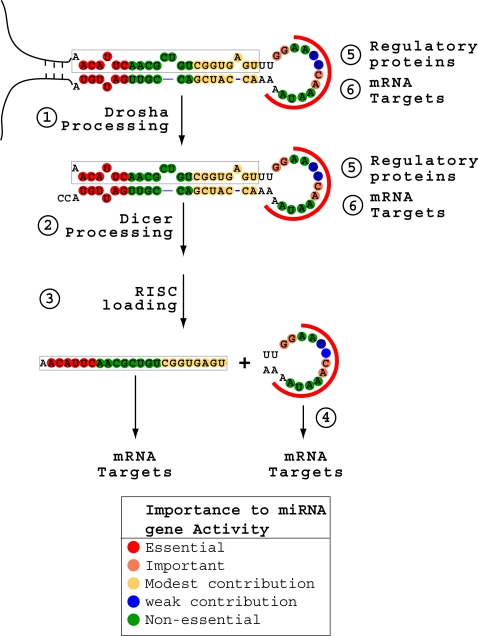
A “heat map” of the functionally important nucleotides in the pre-miR-181a-1 region according to mutagenesis analyses.Color-code was used to illustrate the importance of the pre-miRNA nucleotides to the activity of the miR-181a-1 gene. Possible mechanisms by which pre-miRNA loop nucleotides control the activities of miRNA genes are listed.